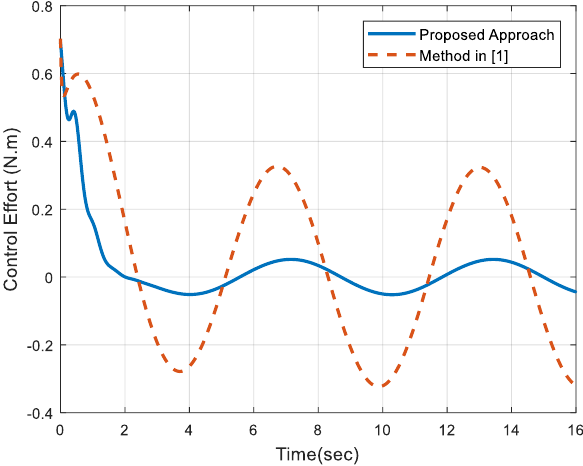
Figure 6. Control effort of suggested approach compared to the method of Golestani et al., 2020, applied in [1].